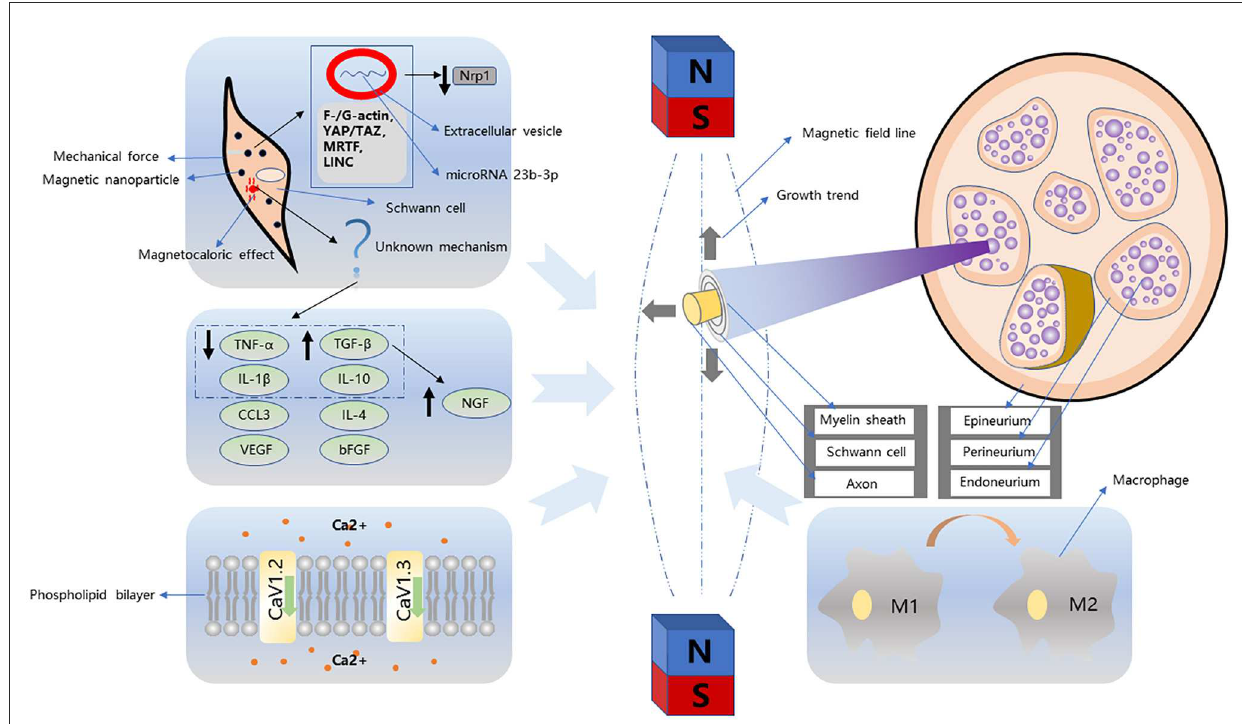
FIGURE1 Magnetism-related nerve regeneration strategies can be divided into simple magnetic fields and magnetic nanoparticles. The growth trend of neurites and Schwann cells in the simple magnetic fields is different. Schwann cells tend to grow parallel to the magnetic field, while neurites tend to be vertical. In addition, this process is accompanied by macrophage transformation, cytokine regulation, and changes in ion channels. Strategies based on magnetic nanoparticles generally combine particles with Schwann cells. In this process, Schwann cells are subject to mechanical action and magnetocaloric effect. In the process of mechanical stimulation, Schwann cells are directionally proliferated in the magnetic field by F-/G-actin, YAP/TAZ, MRTF, LINC pathway, and the downregulation of NRP1 induced by microRNA 23b-3p